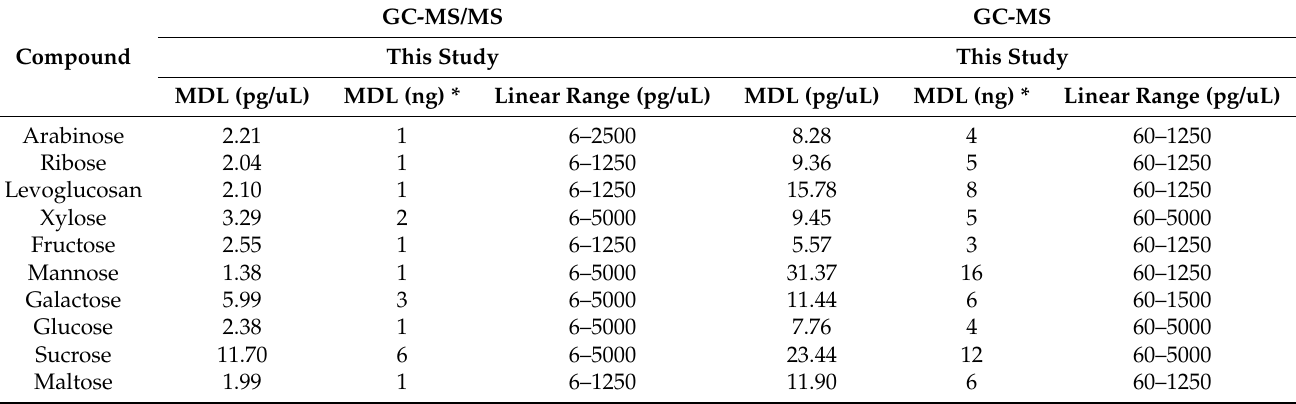
Table 5. MDLs ( n = 10) and linear ranges of MS (at a level of 30 pg/m 3 ) and MS/MS (at a level of 6 pg/m 3 ) for the analysis of saccharides in this study and MDLs measured using HPAEC-MS in Barboro et al., 2015 [10].